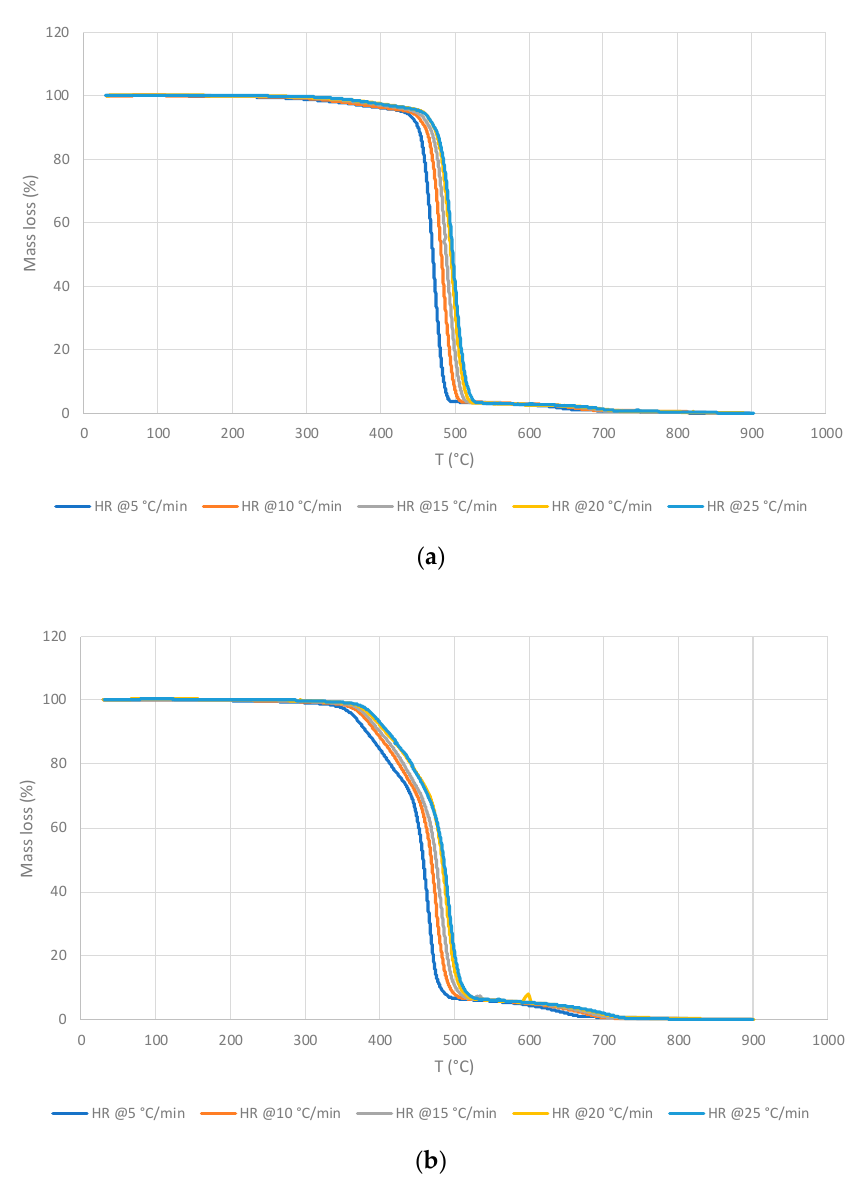
Figure 1. Thermo-gravimetric analysis (TGA) traces of: ( a ) Façade type 1 material; ( b ) Façade type 2 material at different heating rates (HRs) in nitrogen.